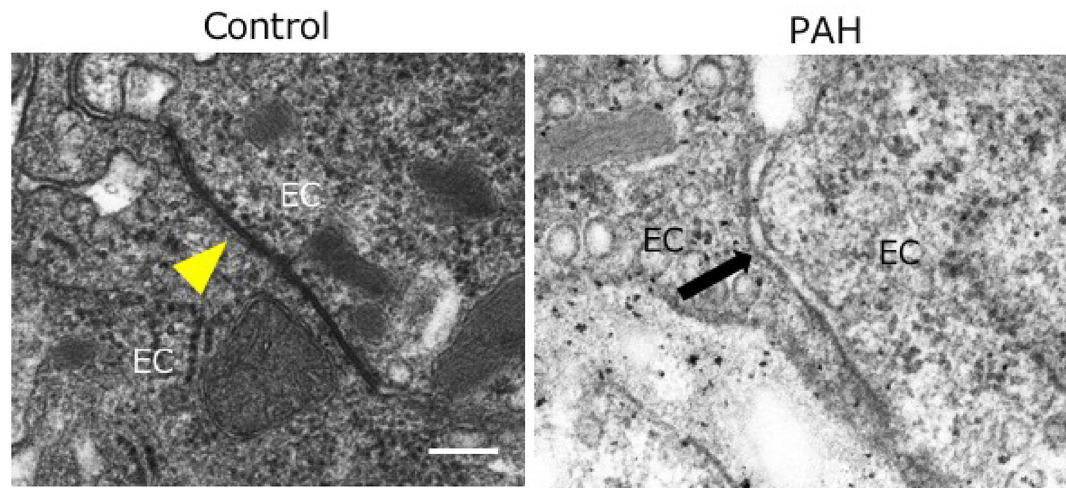
Figure 3. Presence of desmosome between endothelial cells in normal rat and pulmonary hypertension rat. Electronic microscopy showed the presence of desmosome between endothelial cells in control rat (yellow arrow). However, no desmosome was identified in pulmonary hypertension rat (black allow) at 35 days after subcutaneous injection of Sugen. Bar = 200 nm. EC endothelial